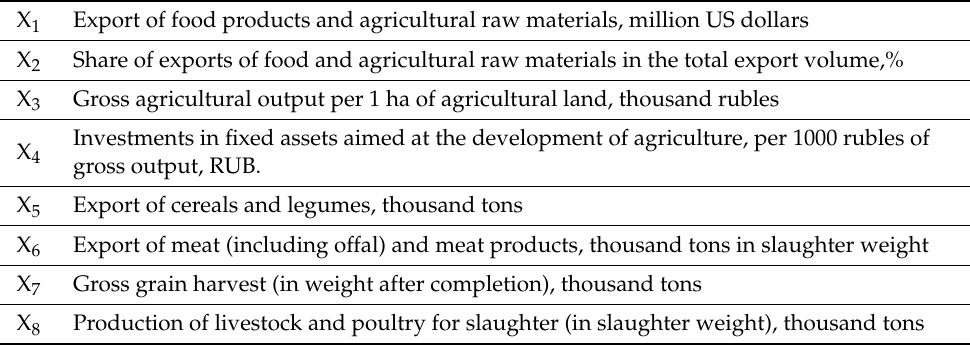
Table 1. The list of indicators involved in the statistical